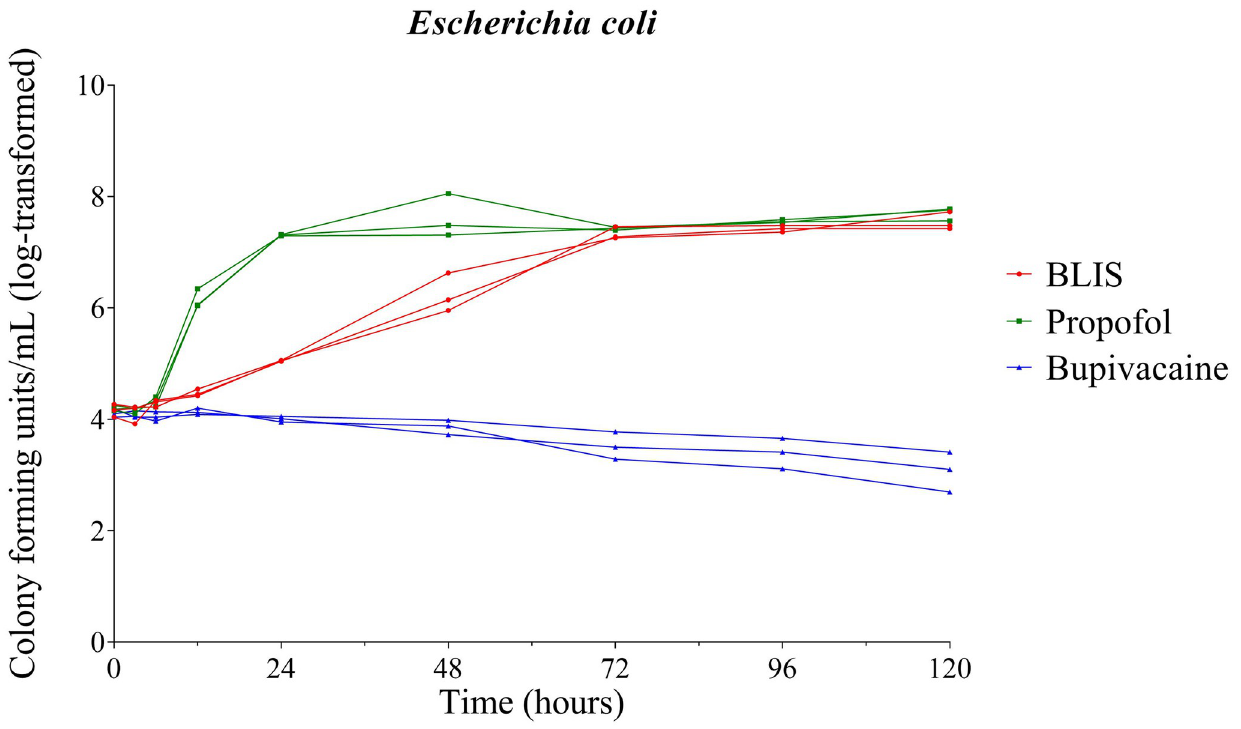
Fig 1. Growth dynamics of Escherichia coli . Growth of inoculated Escherichia coli over time in bupivacaine liposomal injectable suspension (BLIS), propofol, and bupivacaine 0.5%. Each line represents an individual vial; red lines represent BLIS, green lines represent propofol, and blue lines represent 0.5%